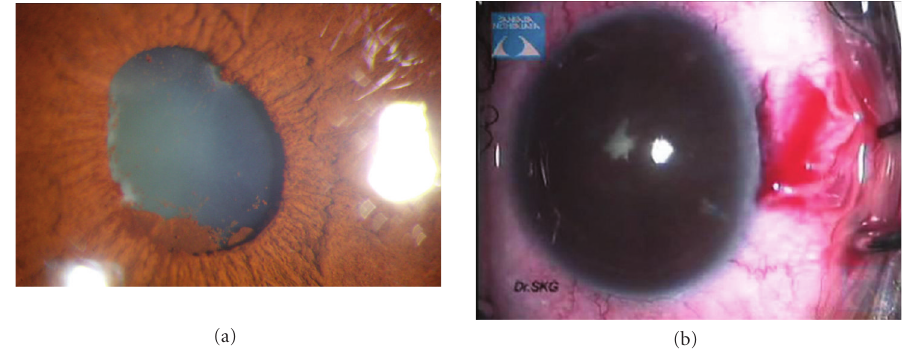
Figure 3: (a) Showing the eye with synechiae at papillary border, pigment deposition on the lens, and an early cataract and (b) showing presence of 360 degree posterior synechiae.